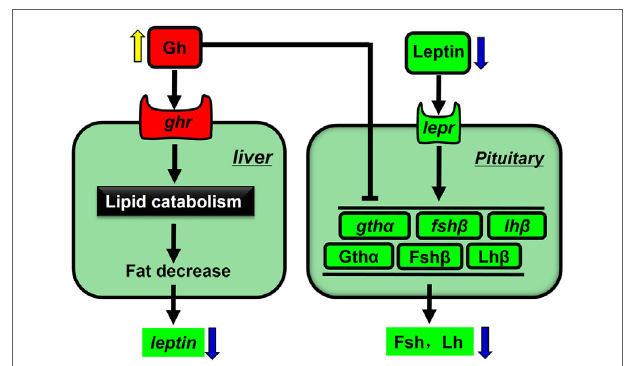
FigUre 7 | Simplified model for the influence of growth hormone (GH) overexpression on disruption of reproduction in common carp. Genes and proteins that are upregulated in GH-transgenic carp are shown in red, while those downregulated are shown in green. Black arrows indicate stimulation, and black blunt-end lines indicate